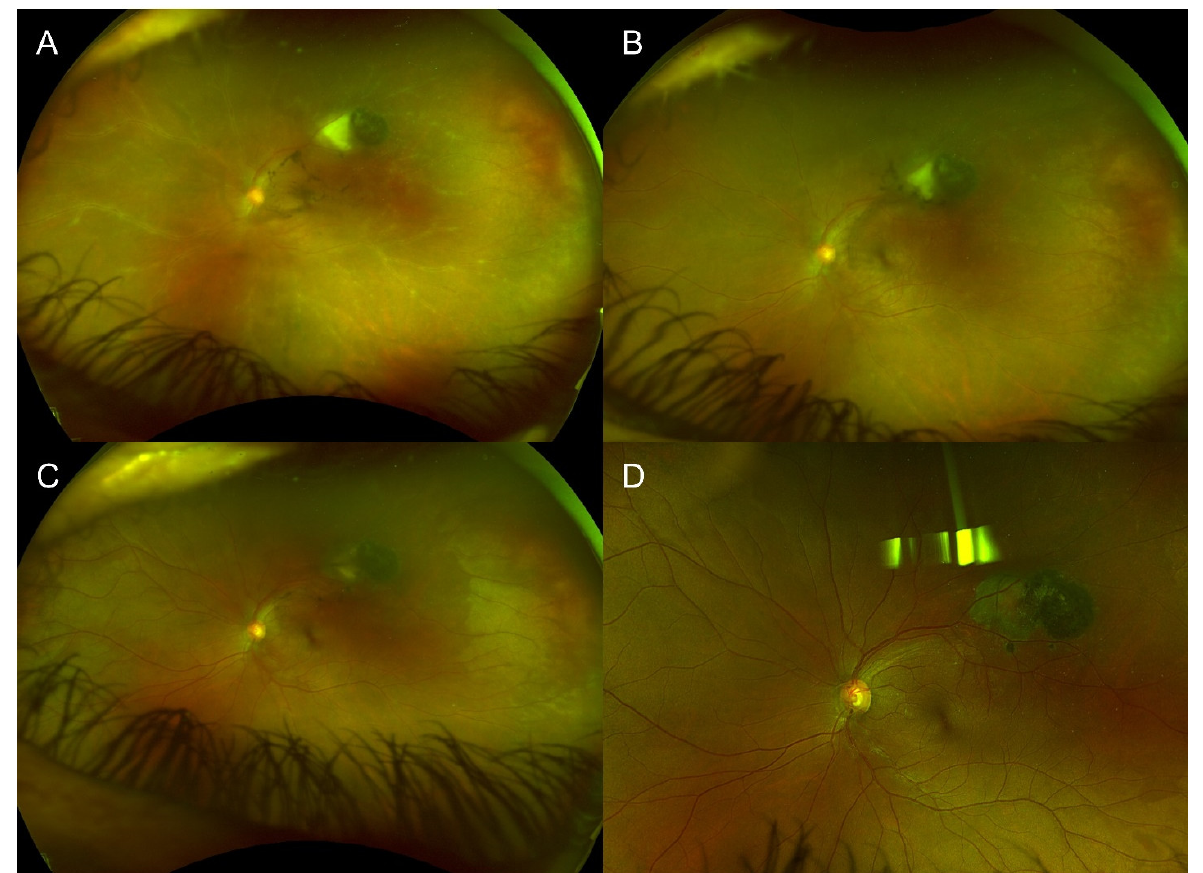
Figure 3. Case 3 with a previous, cicatricial toxoplasmosis scar with recurrence of active toxoplasmosis retinochoroiditis 17 days after COVID-19 vaccination. ( A ) Fundus photography showcasing the old toxoplasmosis scar with an area of active retinochoroiditis adjacent to it. There is diffuse sheathing consistent with vasculitis. ( B ) Three weeks later, the new area of retinochoroiditis has decreased in size and activity as did the vasculitis. ( C ) At seven weeks, there was still an area of activity within the chorioretinal scar, thus the treatment was further extended. ( D ) At final follow- up 4 months later, the area had scarred, and no inflammation was observed.